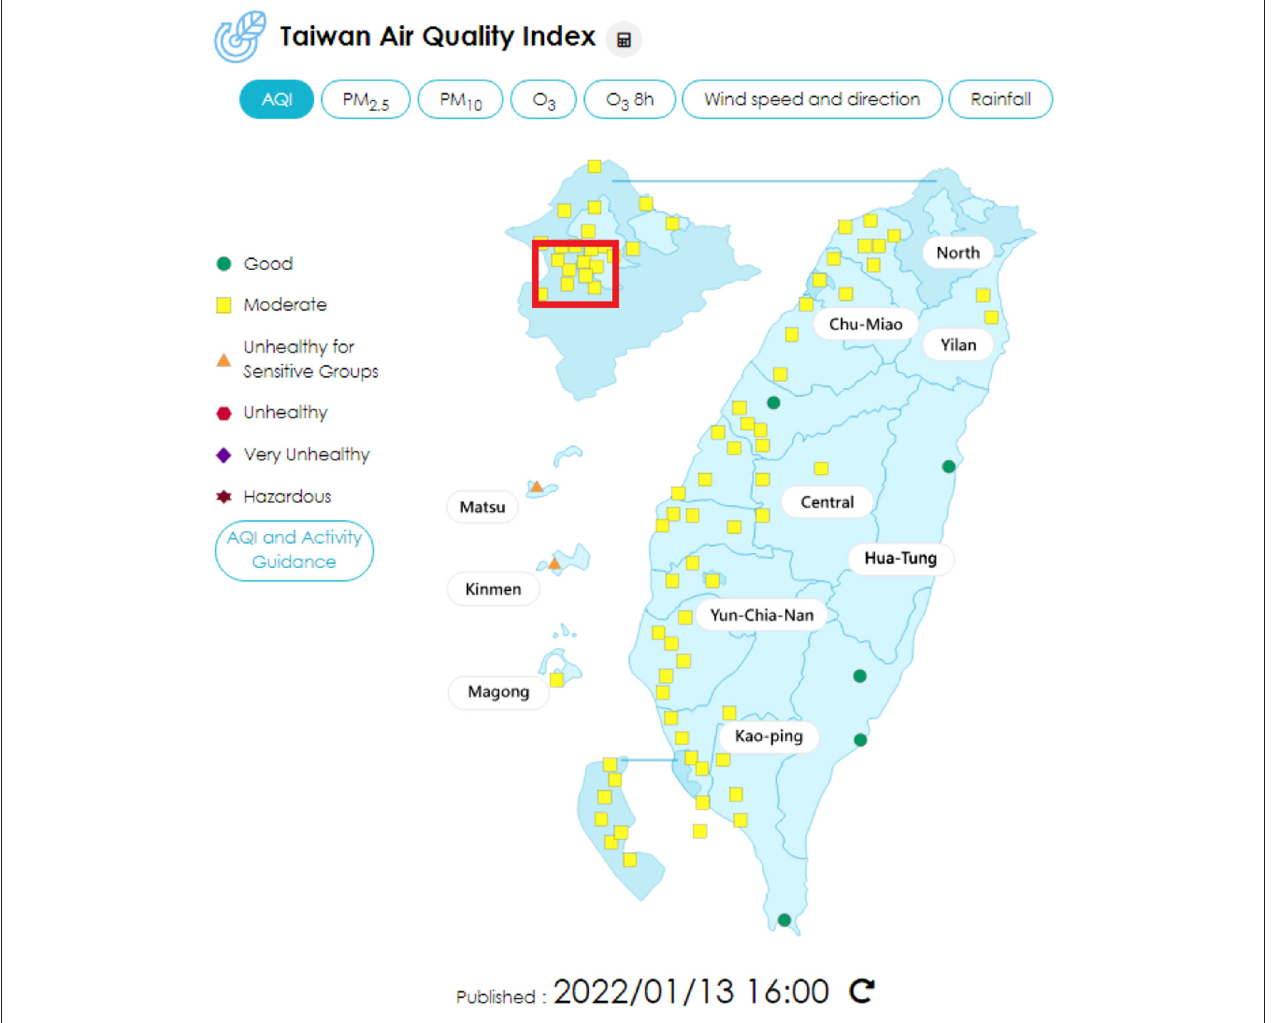
FIGURE 1 | Air quality index distribution in Taiwan, using the data on January 13, 2022 for example. The red block shows the areas involved in this study